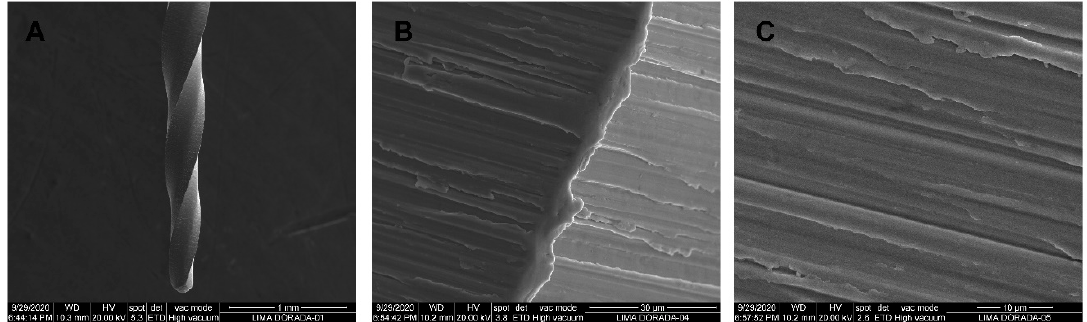
Figure 11. SEM images of CM-Gold Wire alloy PTG endodontic rotary files at ( A ) 100×, ( B ) 3600×, and ( C ) 6500×.